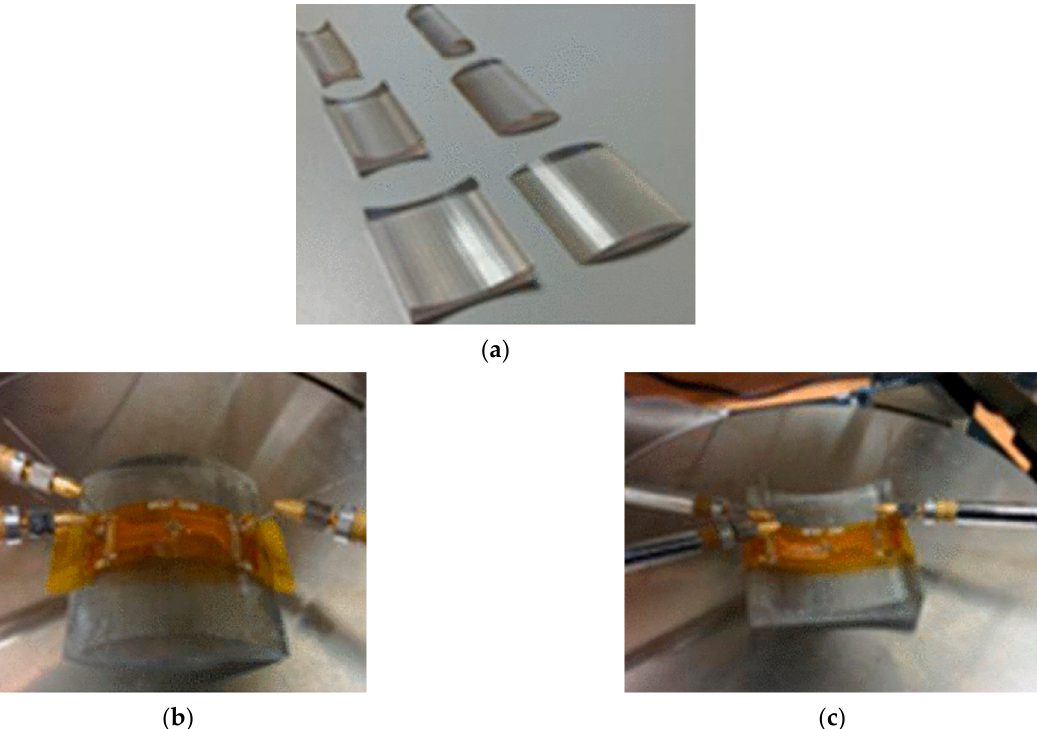
Figure 10. ( a ) 3D printed structures for static bending test, ( b ) convex (tensile) and ( c ) concave (compressive) bending setup of thin chip on flexible foil. Adapted from [92].